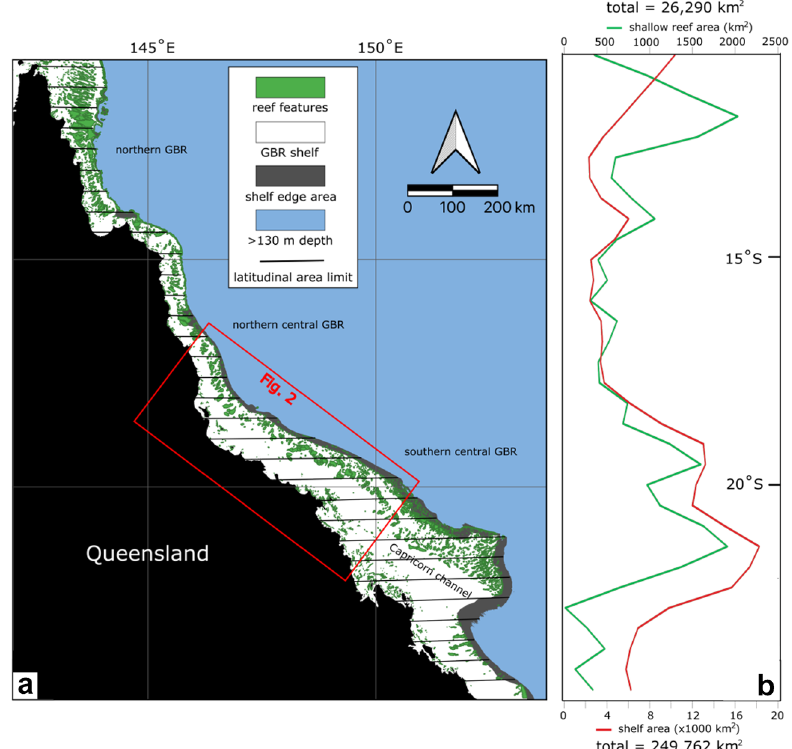
Figure 1. Regional location: ( a ) Present day coastline and bathymetry of the GBR shelf, from Fraser Island in the south to Cape York in the north. Note the shallow reef presence map as interpreted from satellite imagery and bathymetric data 29,50 and the latitudinal areas. ( b ) Shelf area and Holocene reef area as calculated for each latitudinal zone. Note the high correlation of the two curves in the central